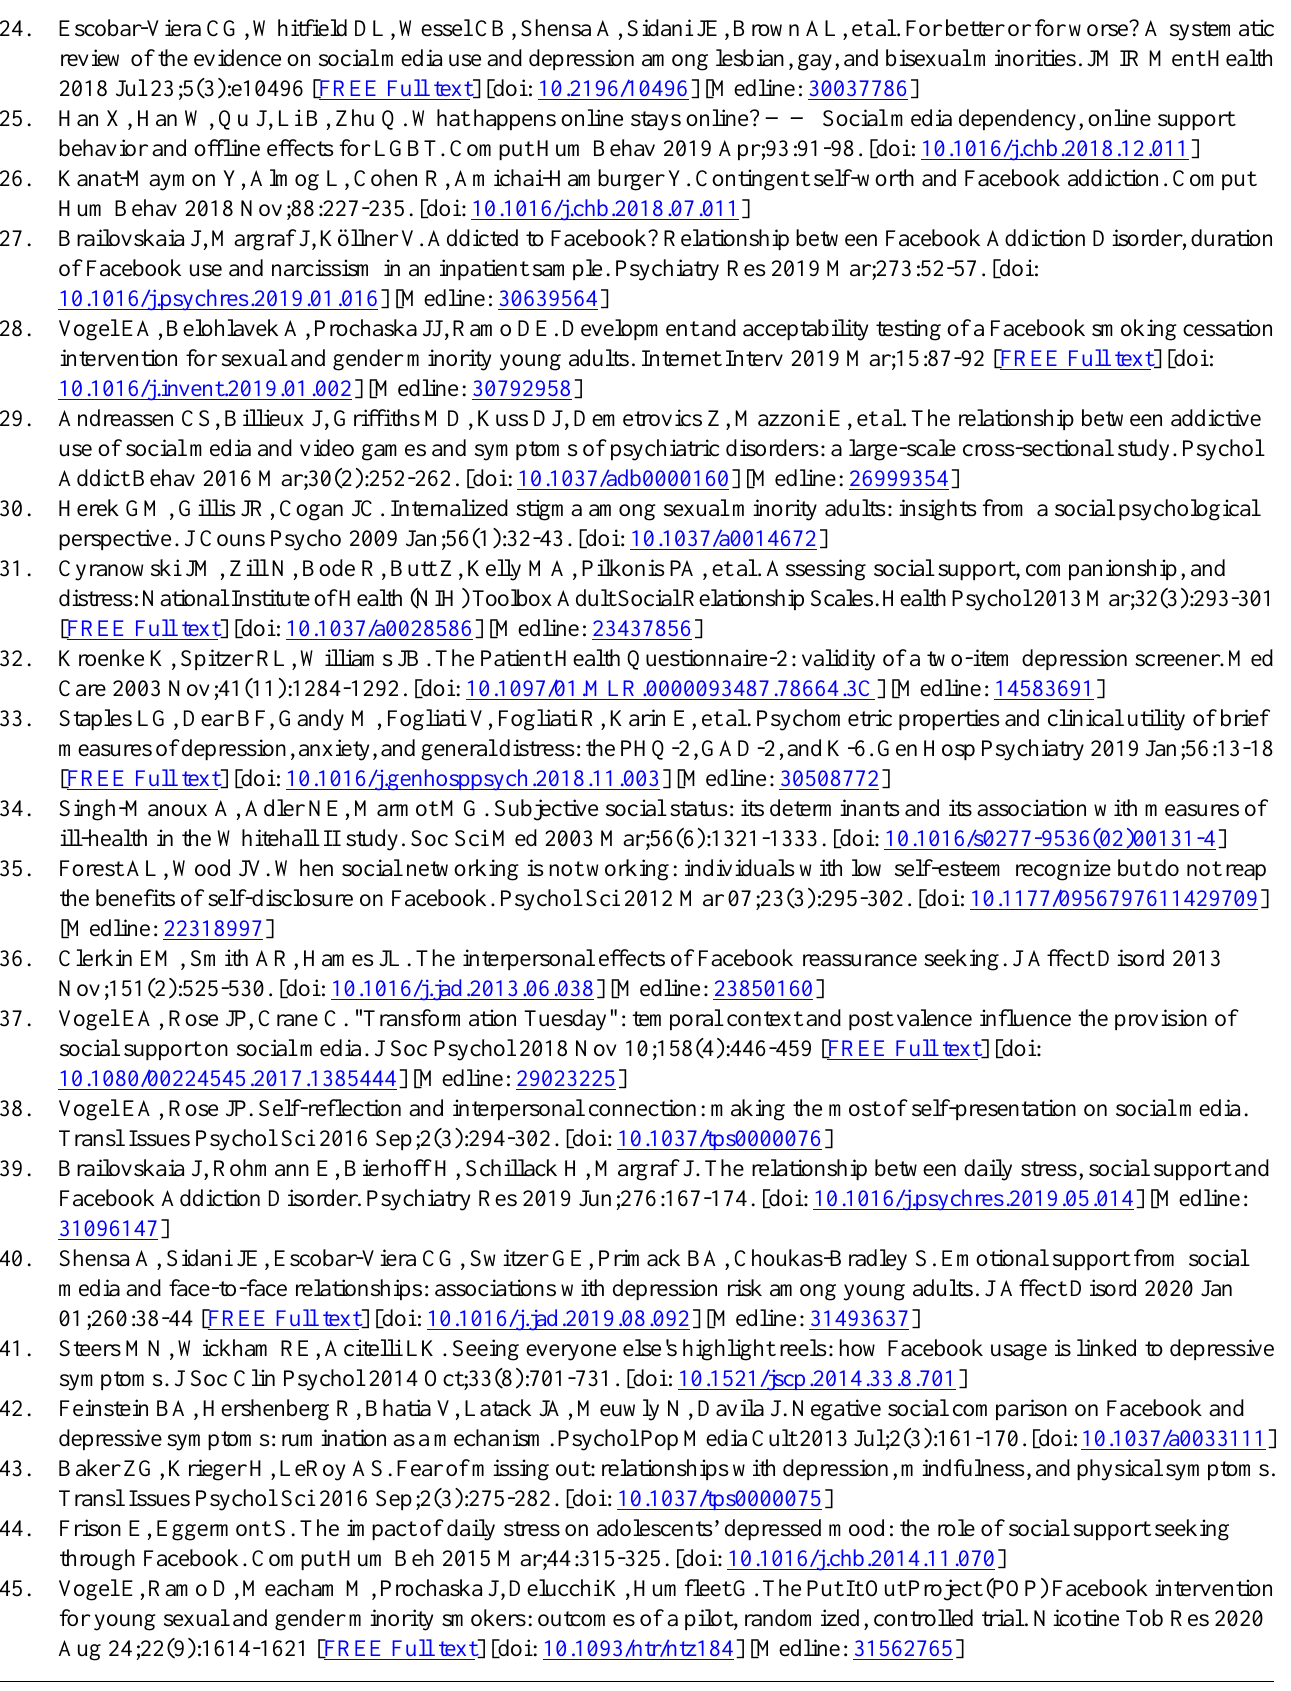
Abbreviations FOMO: fear of missing out